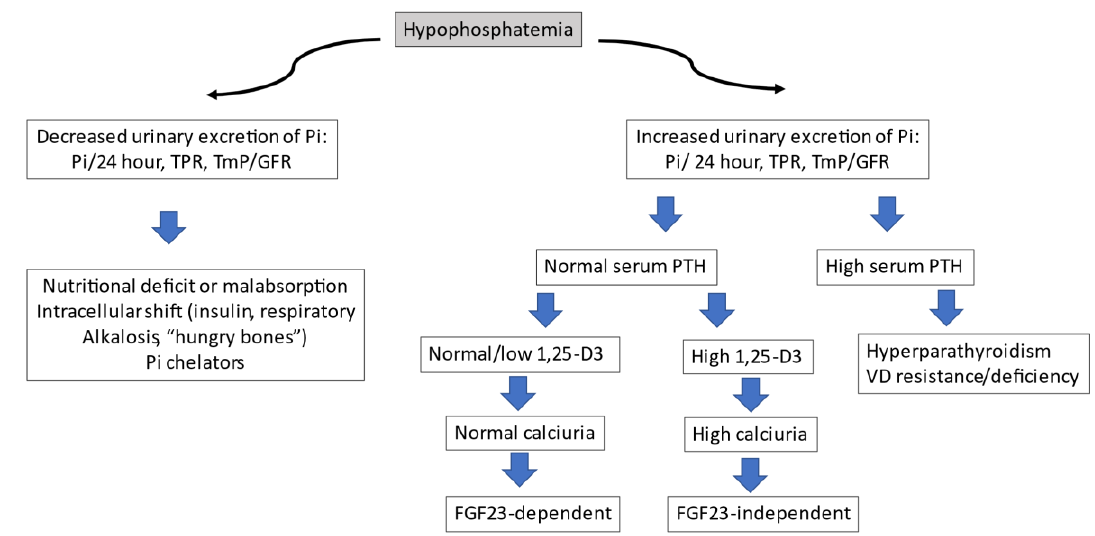
Figure 3. Diagnostic algorithm for hypophosphatemia.